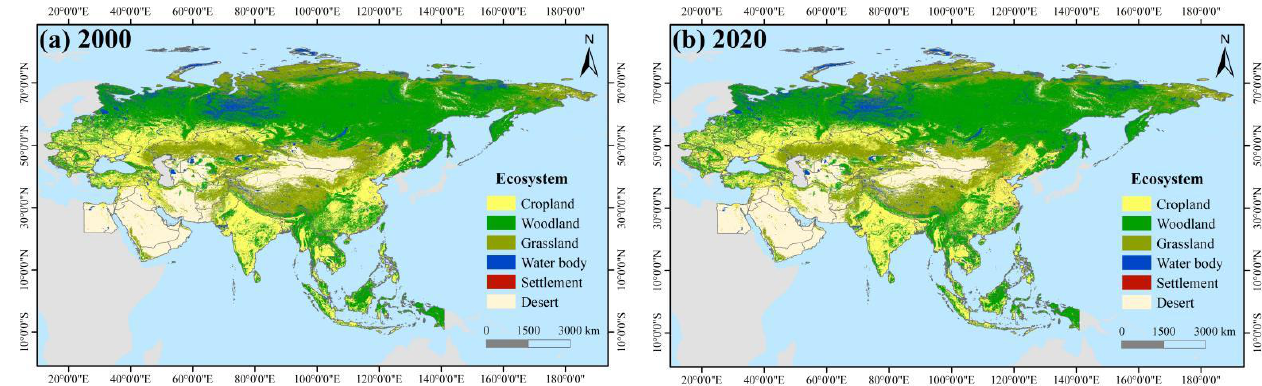
Figure 7. Spatial distribution of ecosystem patterns in the Pan-Third Pole region ( a ) in 2000; ( b ) in